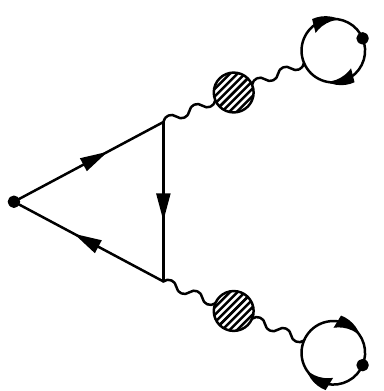
Figure 2 . Diagram contributing to the three point function h j 1 j 1 j s i .